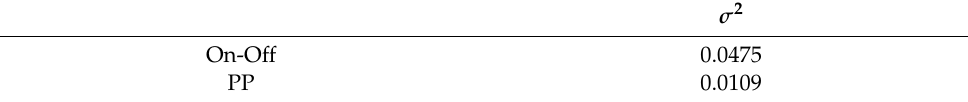
Table 4. Control signal variance ( σ 2